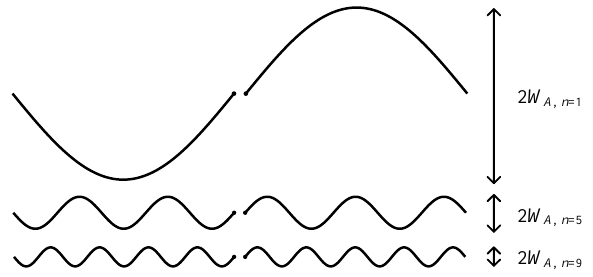
Figure 4. Antennas designed for radiation resistance of 50 Ω on a specific frequency using values 1, 5, and 9 for the n factor. The higher the n factor, the less the antenna width for the same resonance of 1, 5, and 9 for the 𝑛 factor. The higher the n factor, the less the antenna width for the same res- onance frequency and radiation resistance, resulting in a more linear structure. frequency and radiation resistance, resulting in a more linear structure.